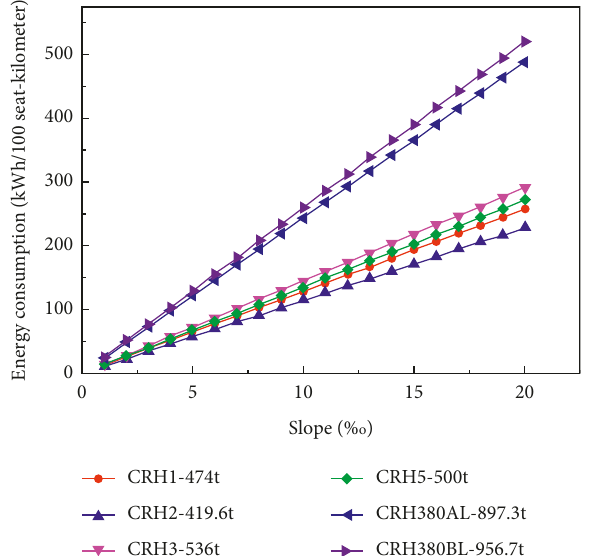
Figure 4: Additional traction energy consumption (kWh/100 seat- kilometer) plus the traction energy consumption required for maintaining a constant speed on the flat slope for various EMU models to cover 10km downhill slopes at different